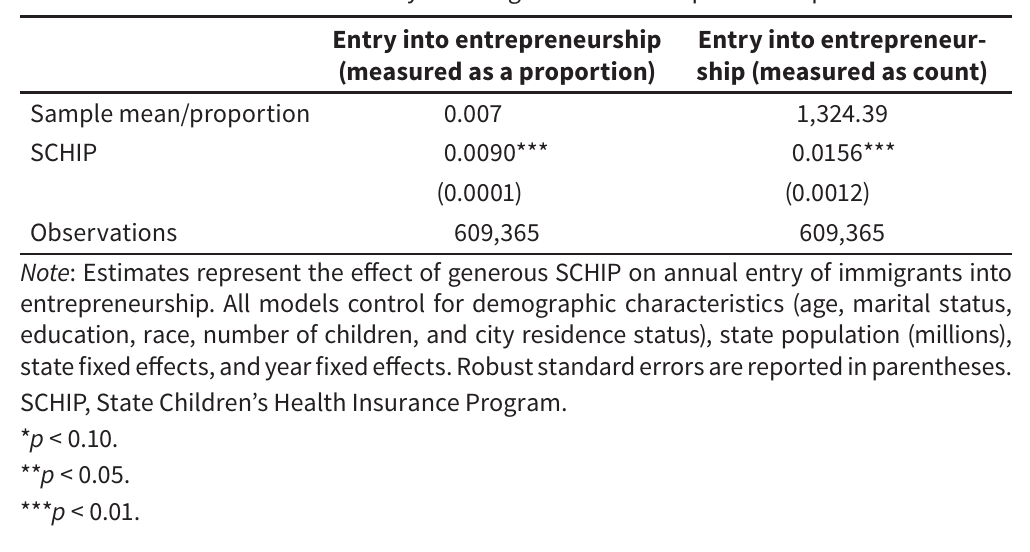
Results with Separate Controls for Immigrant and Native Population Outcome Any self- employment Immigrant entrepreneurs First stage F-stat